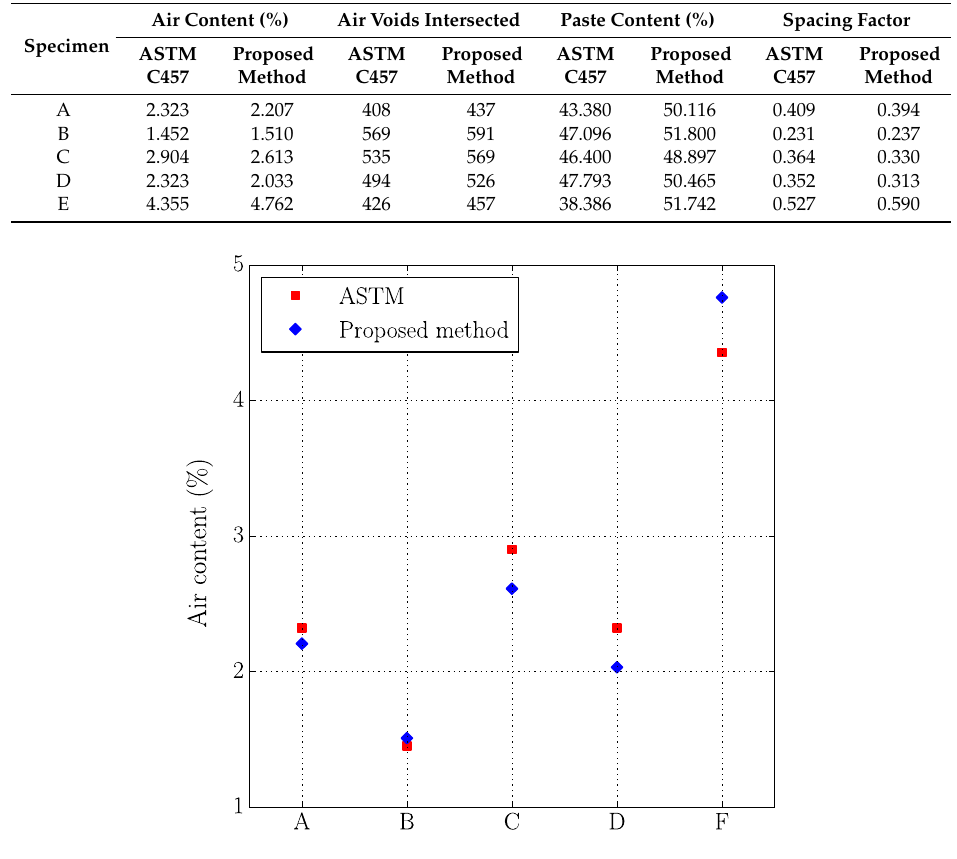
Figure 9. Results of the air content (%) of the slabs studied using the original and the proposed methods.